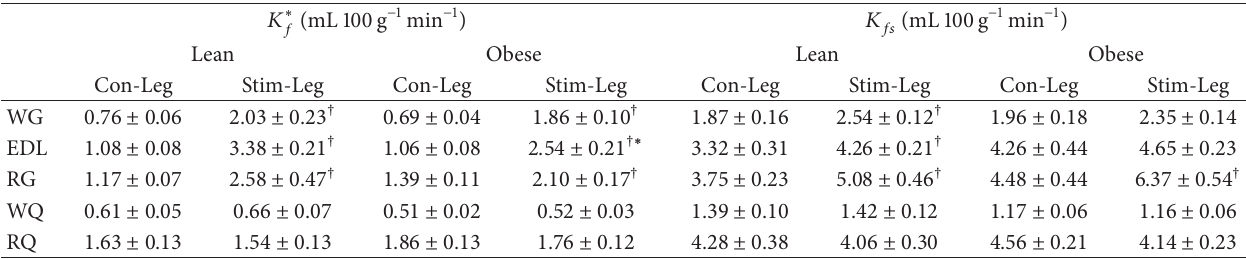
Table 3: 𝐾 ∗ 𝑓 and 𝐾 𝑓𝑠 in individual hind leg muscles in vivo in lean and obese Zucker